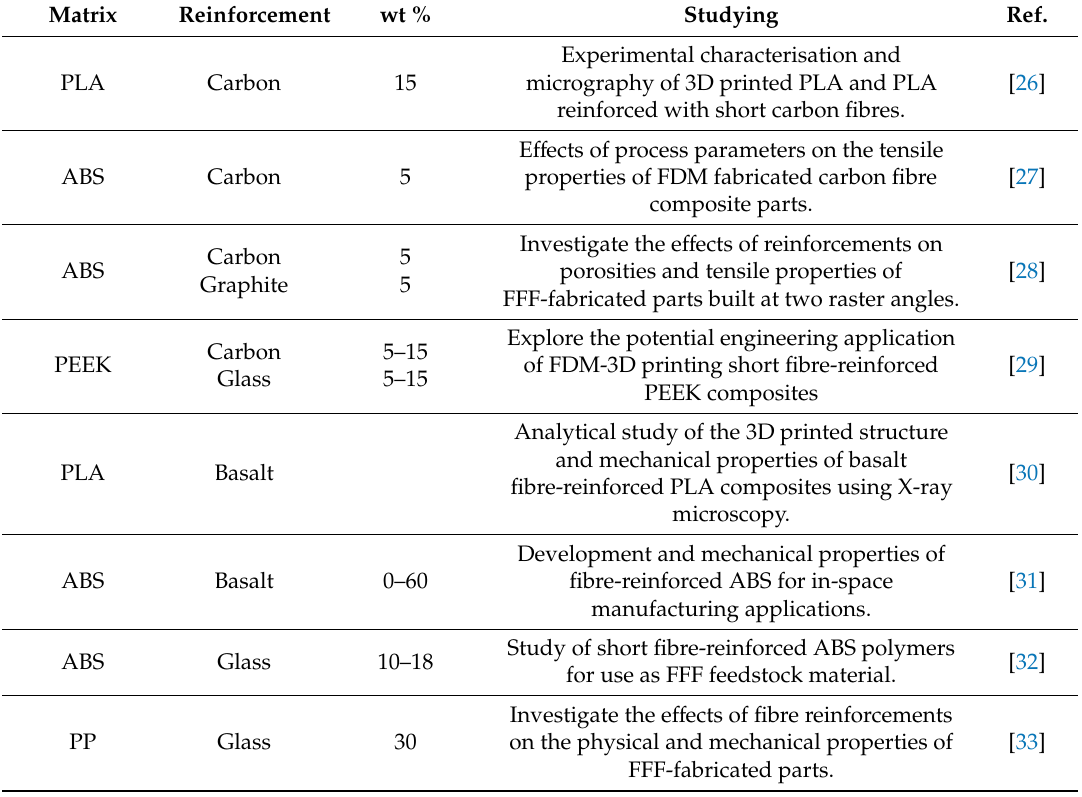
Investigate the e ff ects of fibre reinforcements on the physical and mechanical properties of FFF-fabricated